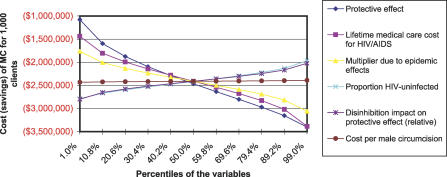
One-Way Sensitivity Analyses of the Cost of 1,000 Male Circumcisions after Deducting Averted HIV Treatment CostsFor each of the varied input values, results shown correspond to the ranges shown in Table 1. The 50th percentile corresponds with the base case. Similarly, the first and 99th percentiles approximate the low and high end of the ranges shown in Table 1 respectively. Parentheses indicate savings. This figure indicates that the cost per HIA adjusted for averted HIV treatment costs is most sensitive to uncertainty in the MC protective effect, lifetime medical care cost for HIV/AIDS, and epidemic multiplier.